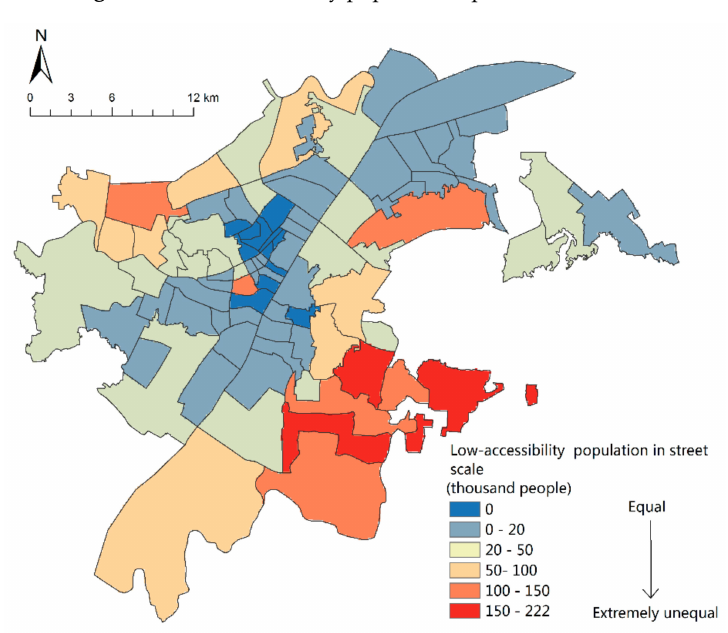
Figure 9. Low-accessibility population at the street